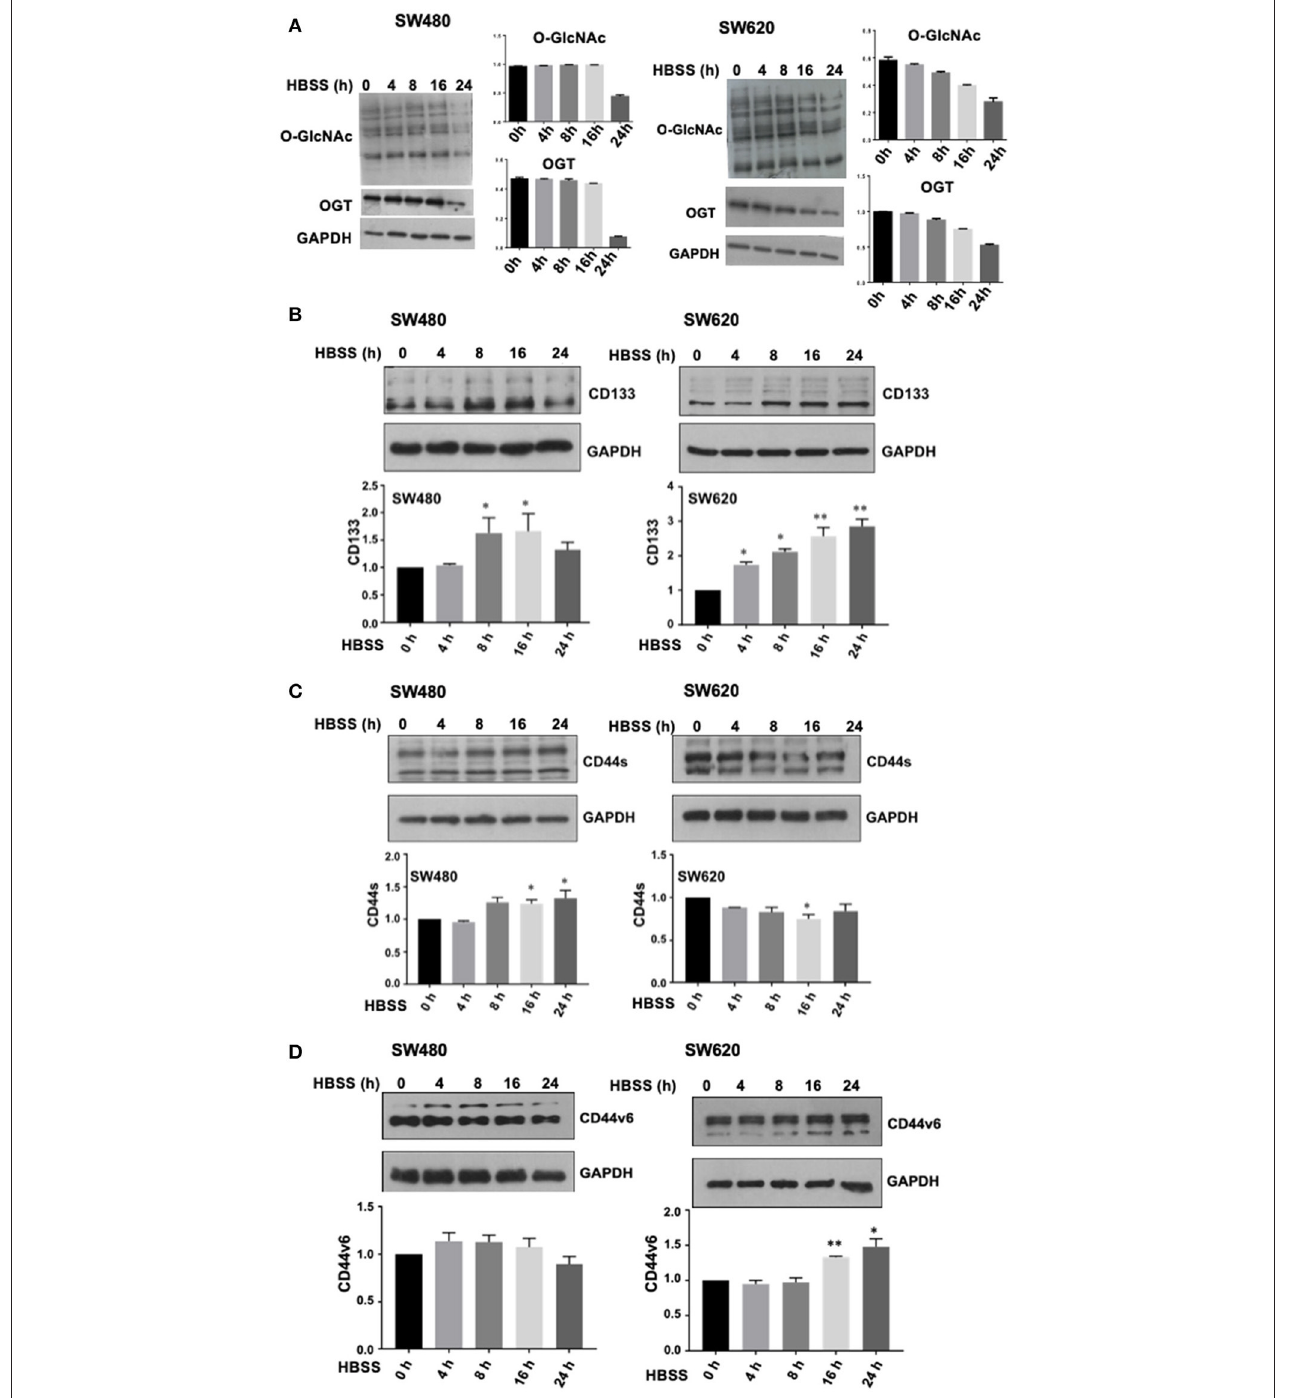
FIGURE 6 | Nutritional stress mimics OGT inhibition effects in cancer stem cells expression. Growth medium from SW480, or SW620 cells, was replaced with Hanks’ Balanced Salt Solution (HBSS) for 4, 8, 16, or 24h. Cells were then collected at these time points and assessed for O-GlcNAcylation levels, OGT expression levels, and stem cell markers expression by Western blot. (A) O-GlcNAcylation levels and OGT expression levels diminish in a time- dependent manner during incubation of cells in HBSS. Results obtained for CD133 expression are shown in panel (B) , CD44 expression in panel (C) and CD44v6 expression levels in panel (D) . Results shown represent the mean ± SEM of three independent experiments. * p = 0.01; ** p = 0.001 ( t -test) compared with control.